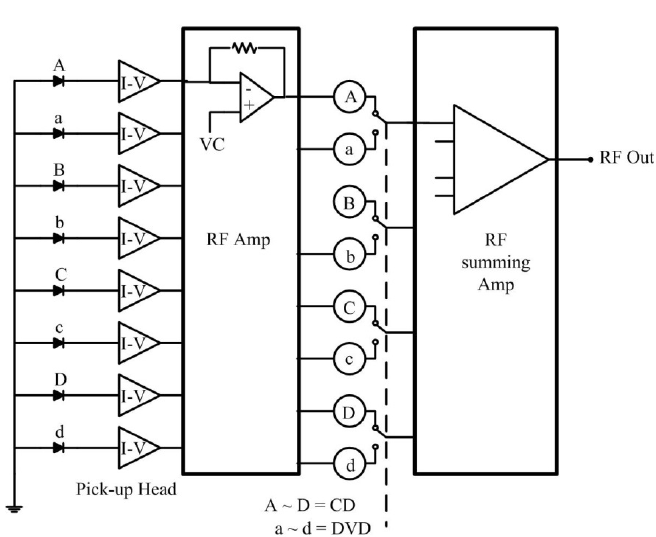
Figure 2. Developed focus error signal of the CD/DVD pick-up head.